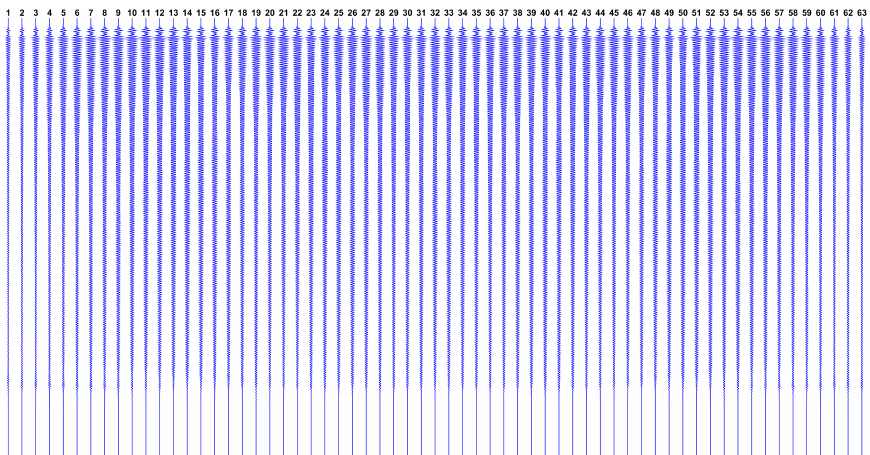
Figure 3. Expected dataset g from the transducers array, with reflectors at every ROI pixel. Notice the effect of the attenuation over time t i , showing that lower signal levels are expected from distant ROI